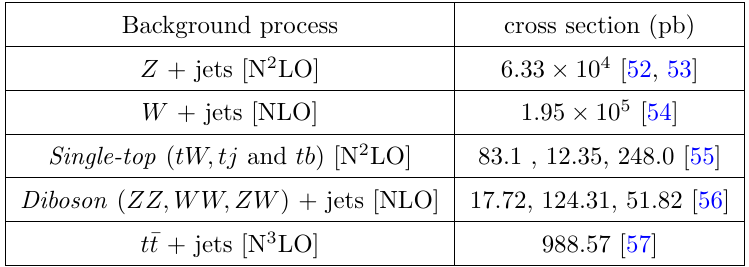
Table 4 . The cross sections for the background processes used in this analysis are shown with the order of QCD corrections provided in